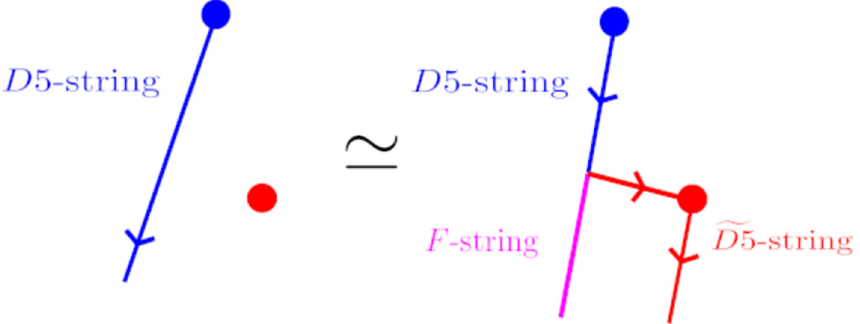
Figure 3 . A D5 string ending on the first defect picks up a unit of F-string charge upon half-way encircling a D7-brane. Therefore, after passing an angle > π/ 2 one may lower its energy by splitting off an F-string. The remaining f D5 string can end on the second